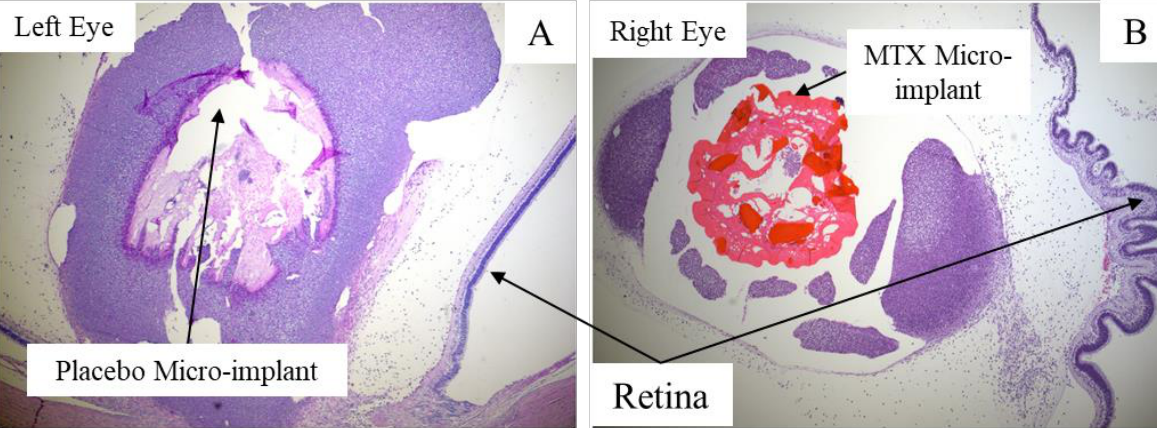
Figure 4. Comparison of concentration of MTX in the vitreous (therapeutic window—shaded region).